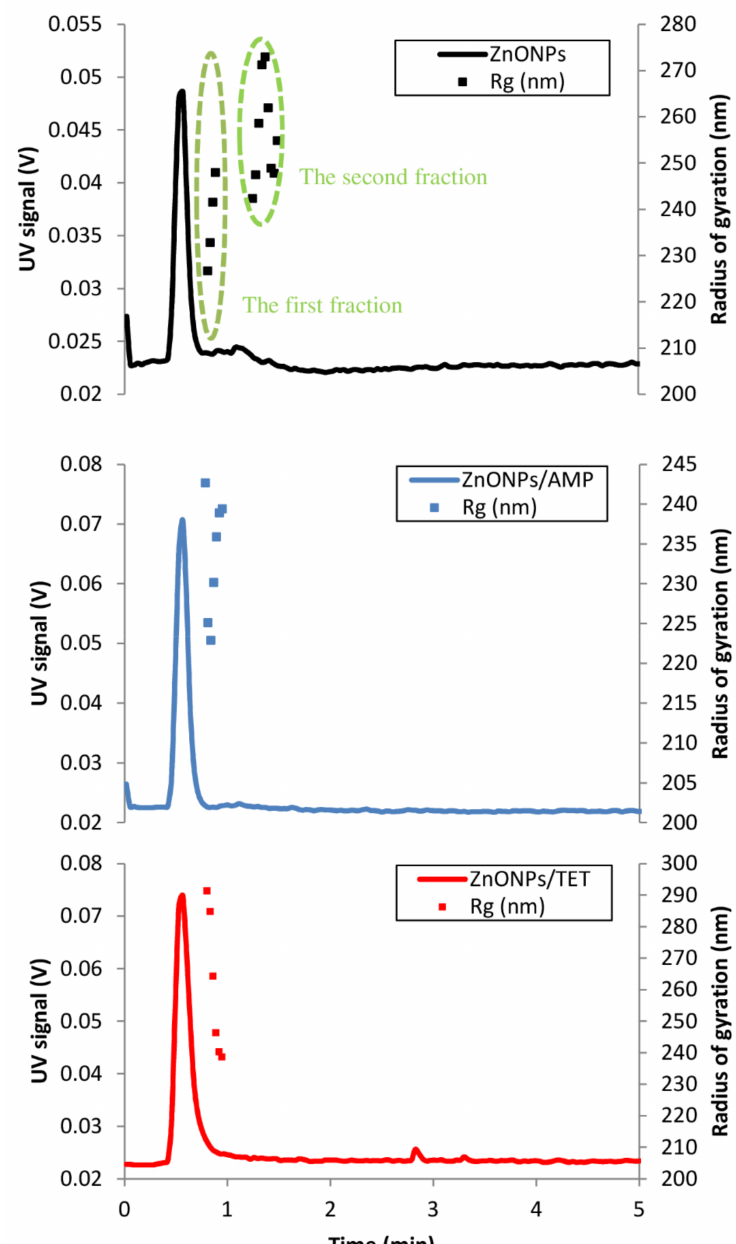
Figure 3. Fractograms of the separation of ZnONPs, ZnONPs/AMP and